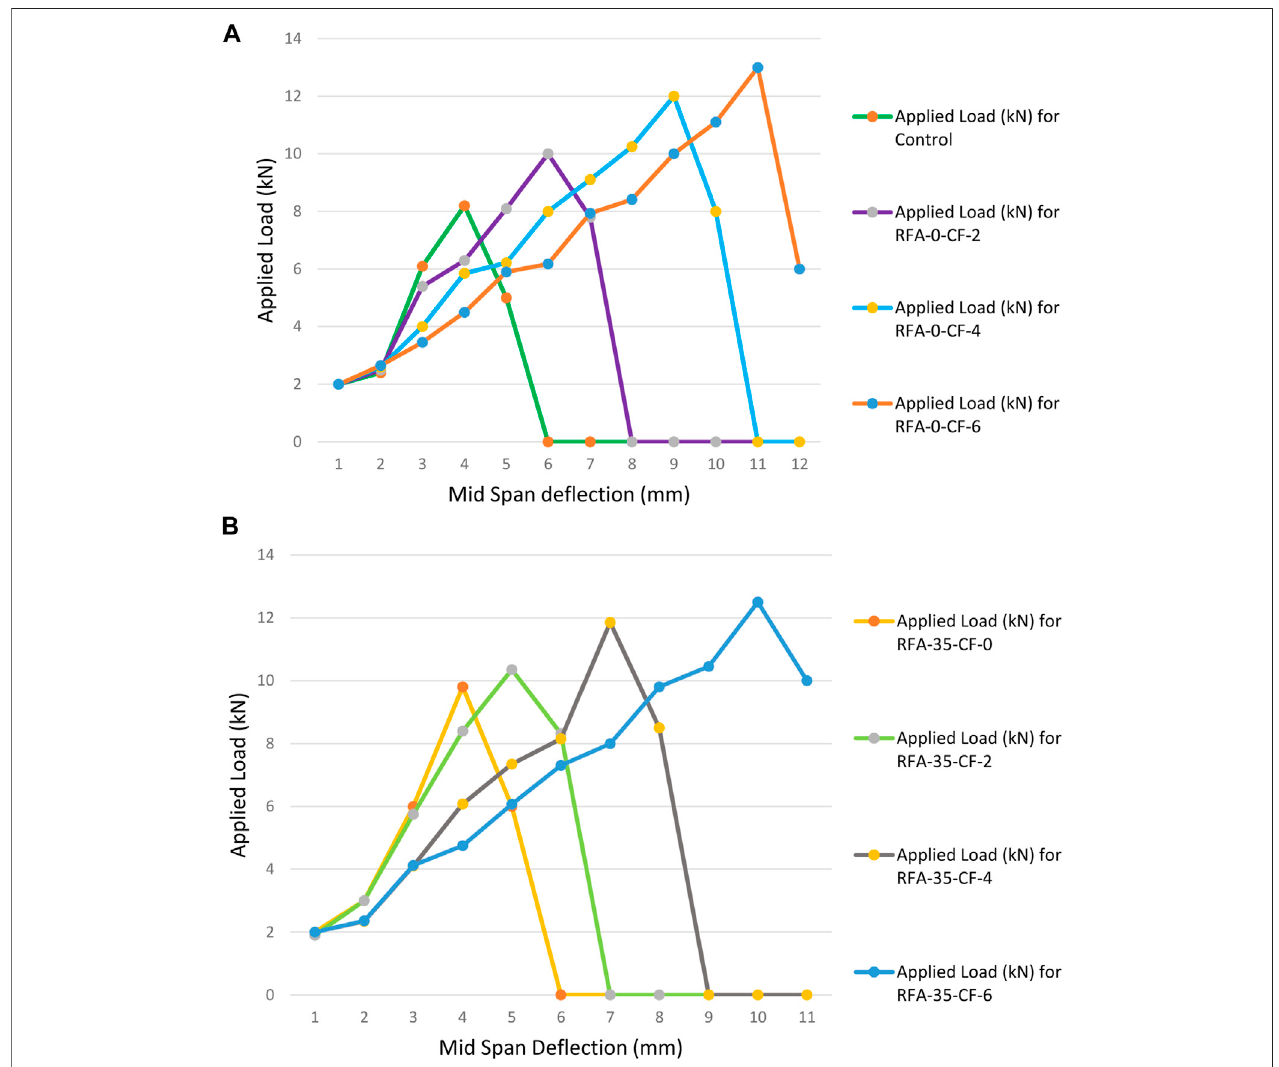
FIGURE 10 | (A,B) Load de fl ection curve of second and third